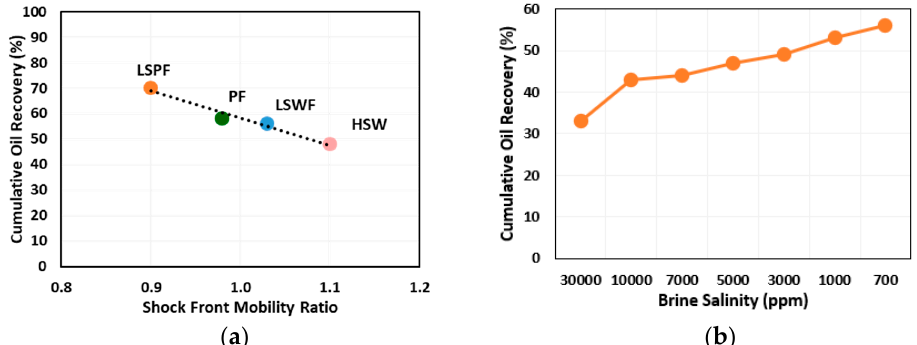
Figure 19. Numerical modeling results showing oil recovery as a function of ( a ) the mobility ratio for different flooding scenarios and ( b ) the brine salinity used for PF [132].